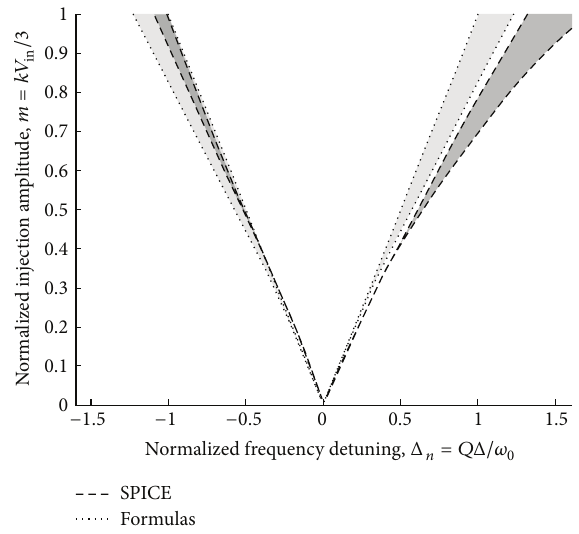
Figure 7: Coexistence regions obtained by SPICE simulations (dark gray region) and by analytical formulas (22) and (34) (light gray